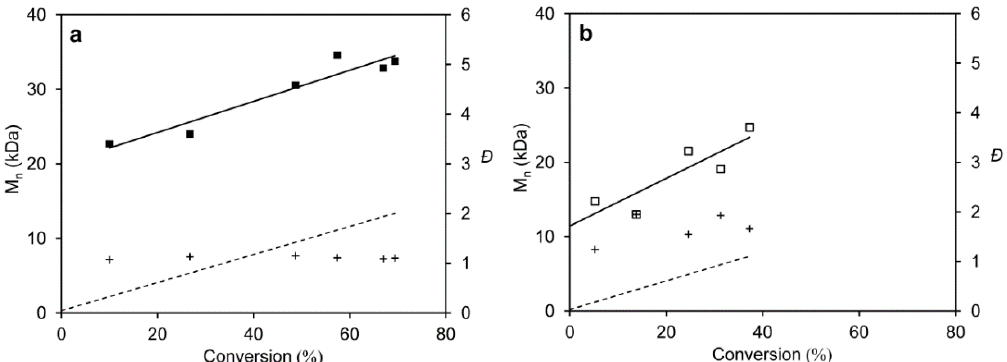
Figure 3. Average molecular weight ( M n ) as a function of the conversion for polymerization of ( a ) DEGMA and ( b ) OEGMA using THF as solvent at 25 ( v / v , %) and M:CTA:I = 500:4:1 mole ratio; (dashed lines) theoretical M n ; and ( + ) dispersity index ( Đ ).